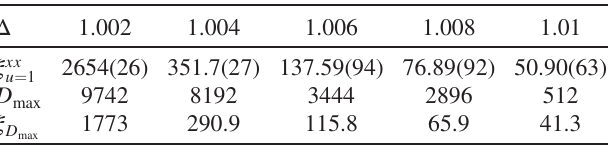
TABLE II. Extrapolated correlation lengths for the XXZ spin- 3 = 2 model. Additionally, we show maximal bond dimension D used in the simulation, as well as MPS correlation length for that D .